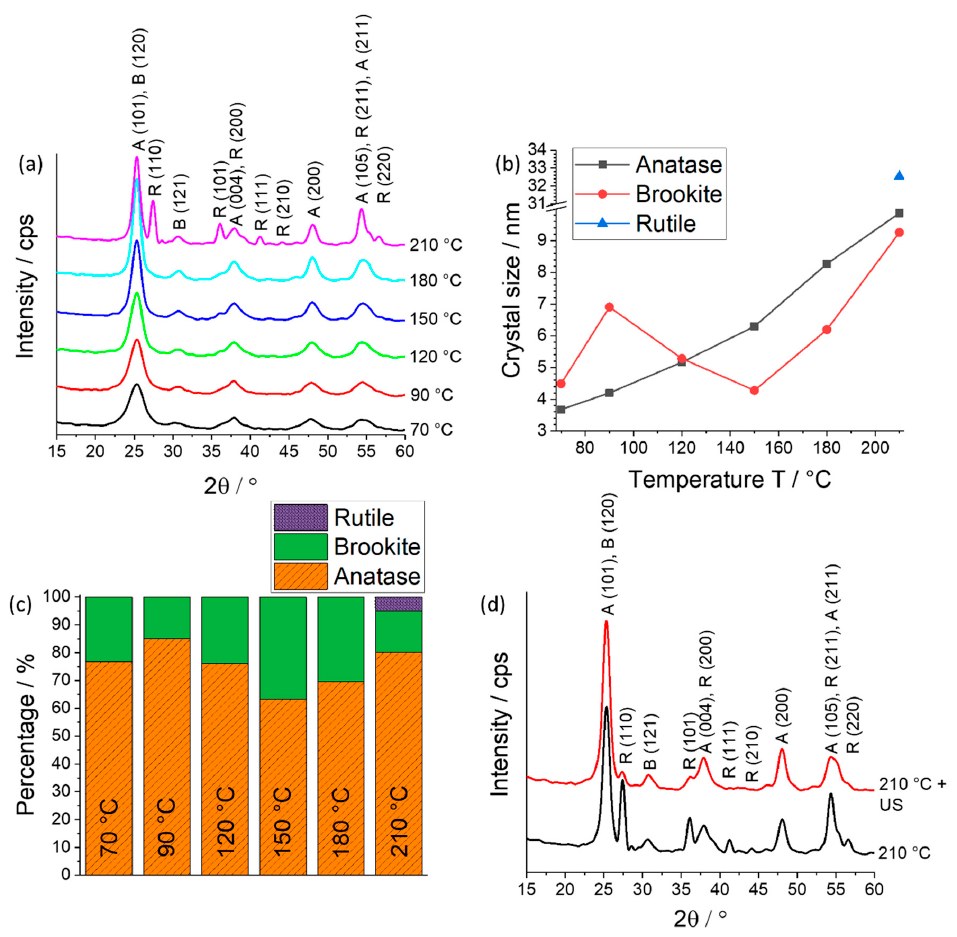
Figure 1. ( a ) XRD (X-ray diffraction) pattern of TiO 2 nanoparticles synthesized at different temperatures. ( b ) Crystal size against the synthesis temperature calculated by the Scherrer formula. ( c ) Percentage of phase type of TiO 2 nanoparticles prepared at different temperatures. ( d ) Comparison of the XRD pattern of TiO 2 nanoparticles synthesized at 210 ◦ C with and without ultrasonic treatment. The XRD pattern were smoothened with a 17 point FFT (fast Fourier transform